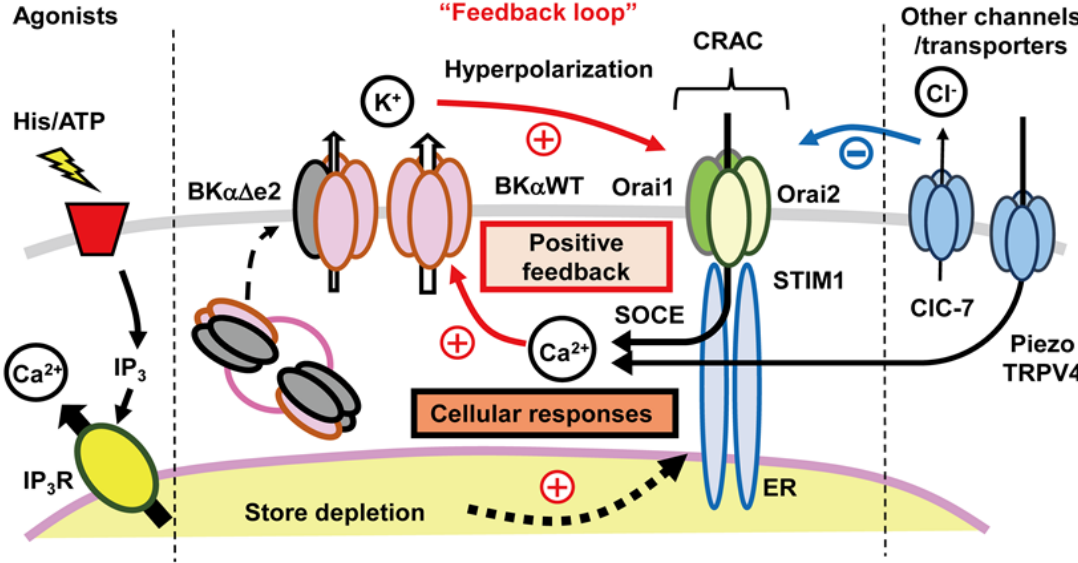
Figure 6. When agonists such as histamine (His) and ATP bind to their receptors, a Gq-mediated phospholipase C enzymatic reaction is triggered. This produces IP 3 that binds to IP 3 receptors (IP 3 R) and releases Ca 2+ from the ER. The resulting Ca 2+ store depletion causes subsequent SOCE through CRAC channels consisting of Orai1, Orai2 and STIM1. Increases in [Ca 2+ ] i activate K Ca channels such as BK Ca and IK Ca channels and cause membrane hyperpolarization. This hyperpolarization further promotes SOCE, thus forming a positive feedback loop that results in a maintained Ca 2+ influx that can evoke various kinds of cellular responses. Transmembrane Ca 2+ fluxes are also mediated by other kinds of Ca 2+ -selective channels such as Piezo and TRPV4 channels. These channels sense different types of mechanical stimuli and then transduce them into specific and spatially localized [Ca 2+ ] i profiles. Cl - channels/transporters such as ClC-7 are also functionally expressed in a human chondrocyte cell line. ClC-7 depolarizes resting membrane potentials and reduces Ca 2+ influx through voltage-independent Ca 2+ channels. In this diagram the splice variant, BKα∆e2, is shown to negatively regulate BK Ca channel activity by forming heterotetramers with BKαWT (see legend of Fig. 4).